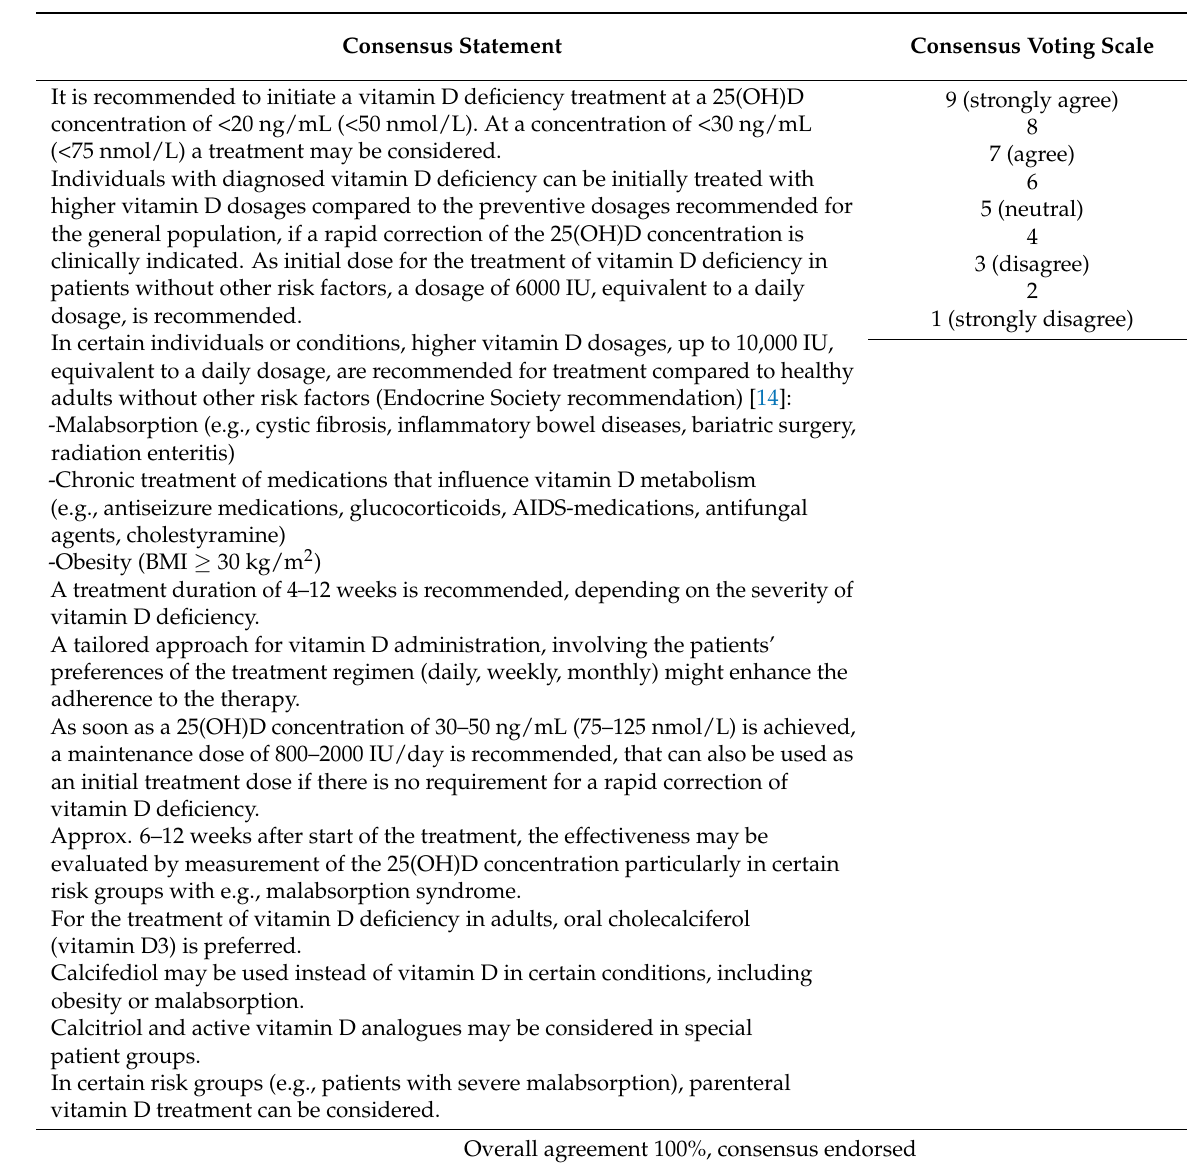
Table 6. Statement regarding treatment of vitamin D deficiency in